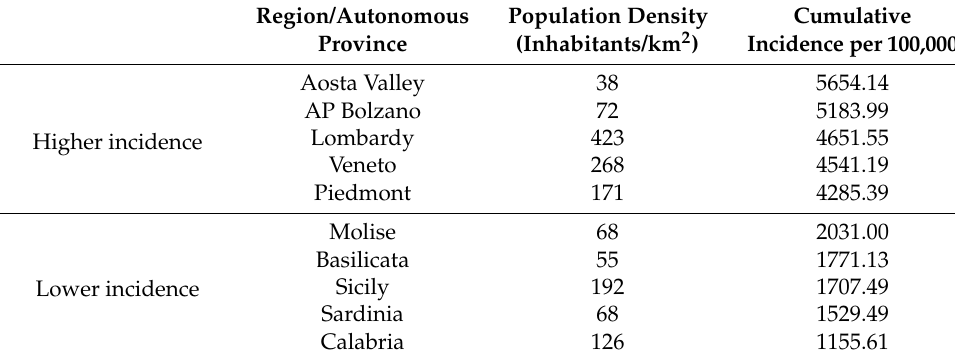
Table 2. Regions with higher and lower cumulative incidence per 100,000 inhabitants (modified from [39,41]).